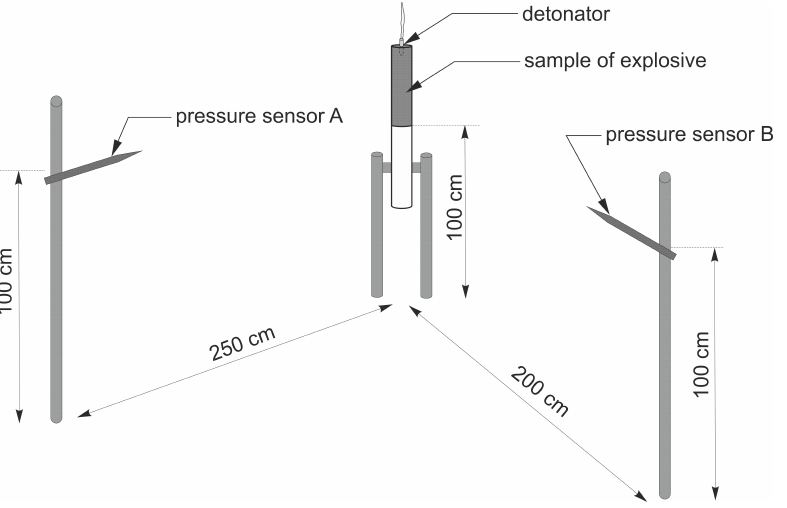
Figure 1. Outline of the experimental set-up for determining shock wave